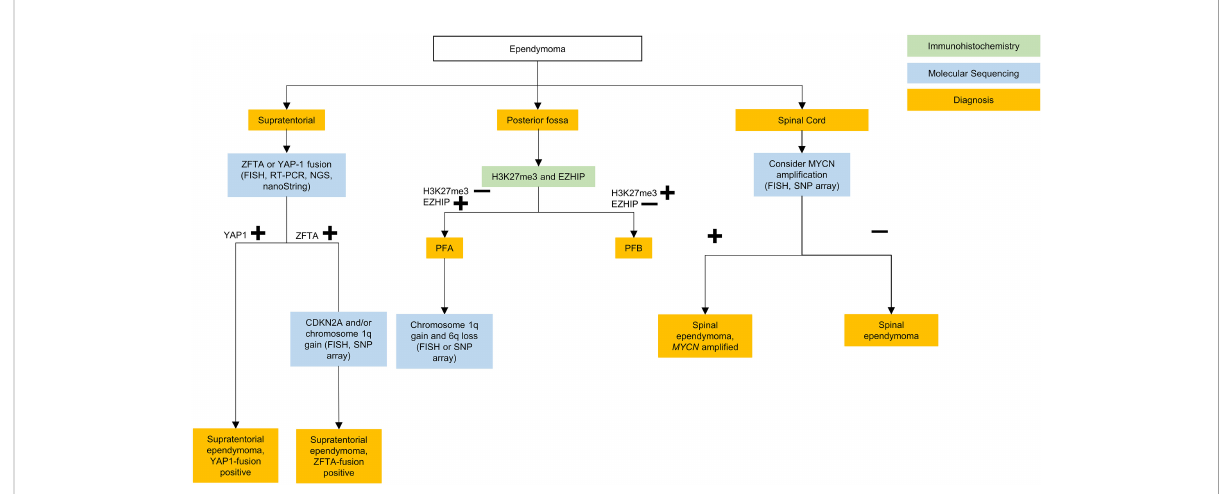
FIGURE 4 Testing algorithm for adolescent and young adult ependymomas. ZFTA, zinc fi nger translocation associated; YAP1, yes-associated protein 1; FISH, fl uorescence in situ hybridization; RT-PCR, reverse transcriptase polymerase chain reaction; NGS, next generation sequencing; PFA, posterior fossa type (A) PFB, posterior fossa type (B) MYCN, N-myc proto oncogene; CDKN, cyclin-dependent kinase inhibitor; SNP, single nucleotide